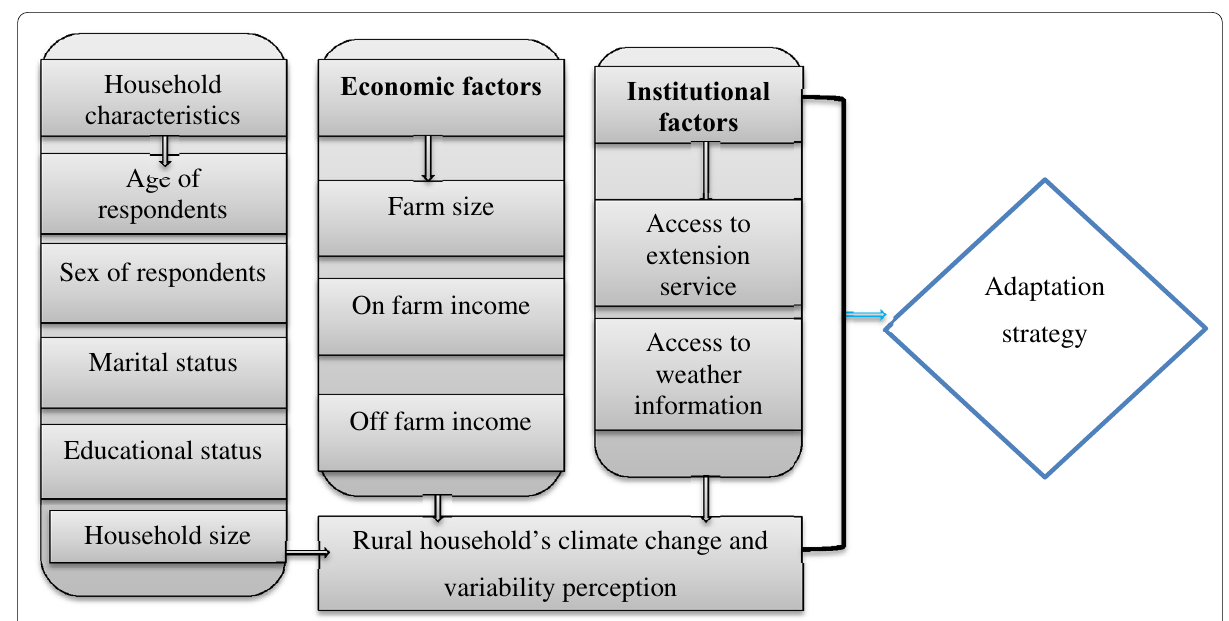
Fig. 1 Conceptual framework for factors affecting the choice of adaptation strategies